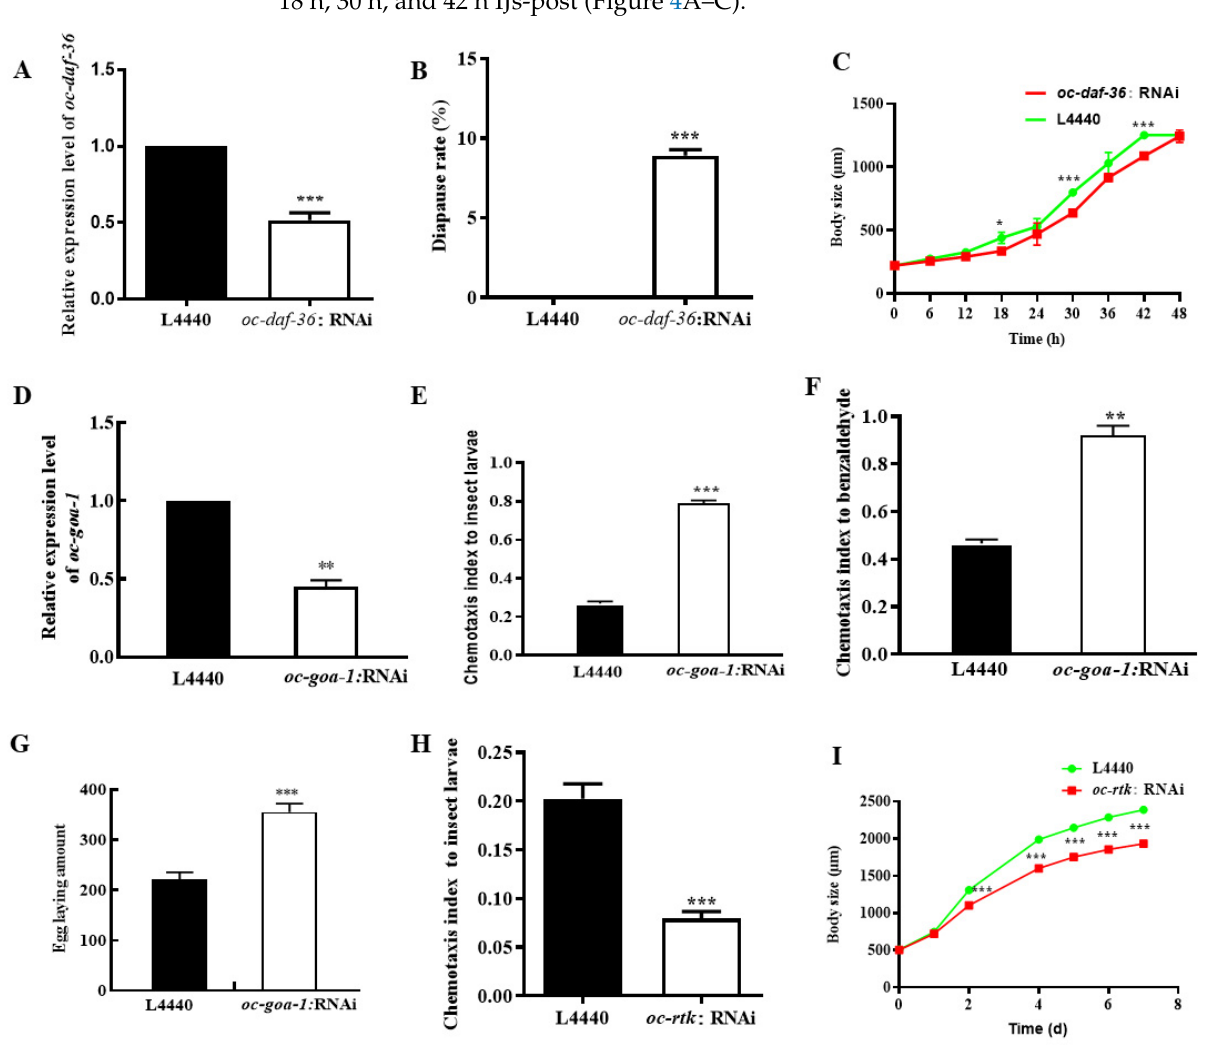
Figure 4. Identification of functions of oc-daf-36, oc-goa-1 , and oc-rtk in regulating chemotaxis and fecundity of O. chongmingensis . ( A ) The expression level of oc-daf-36 is knocked down by 48.3% in oc-daf-36 :RNAi nematodes. ( B ) The diapause rate of IJs of oc-daf-36 :RNAi nematodes is 8.9%. ( C ) Adults of oc-daf-36 :RNAi nematodes need four hours more to reach the largest length. ( D ) The expression level of oc-goa-1 is knocked down by 55.2% in oc-goa-1 :RNAi nematodes. ( E ) Increased chemotaxis to wax worms in oc-goa-1: RNAi O. chongmingensis . ( F ) Increased chemotaxis to benzaldehyde in oc-goa-1: RNAi O. chongmingensis . ( G ) Increased number of eggs laid in goa-1 :RNAi O. chongmingensis was increased. ( H ) Decreased chemotaxis to wax worms in oc-rtk: RNAi O. chongmingensis . ( I ) Decreased body length in oc-rtk: RNAi O. chongmingensis . * p < 0.05; ** p < 0.01; *** p < 0.001.